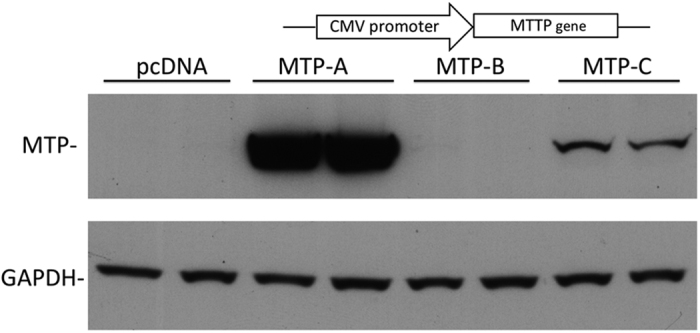
Cellular expression of human MTP splice variants.MTP-A, -B, and -C were cloned into the pcDNA3.1 vector (see schematic at top) and transfected into HEK 293 cells. Three days post transfection, equal amounts of cell lysate were separated by SDS-PAGE. MTP protein was detected by immunoblot and quantitated by densitometry using GAPDH as load control. No protein was detected from MTP-B. MTP protein levels in MTP-C transfected cells were ≈10% of the MTP protein levels in MTP-A transfected cells.